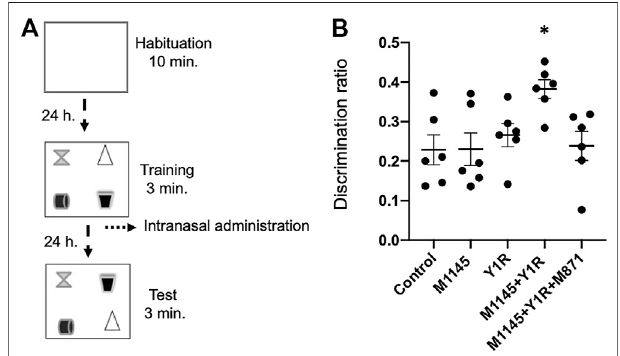
FIGURE 1 | Behavioural effects produced by Galanin 2 receptor agonist (M1145) and the Neuropeptide Y Y1 receptor (NPY Y1) agonist alone and in combination on retrieval in the Object-in-Place memory task. (A) Schematic representation of the procedures followed to perform the behavioural experiments in the Object-in-Place task. The animals performed the task in three phases, separated 24 h from each other, where they explored freely during 10 min in the habituation phase without objects, 3 min in the training phase with fourdifferentobjects, and fi nally3 min inthetest phase withtwoof the objects with the exchanged position. The pharmacological treatments were administered intranasally to the different groups of animals 24 h before the testing phase. (B) The graphic shows the ability of rats to discriminate the exchanged objects at 24 h post-training after the administration of M1145 in combination with the NPY Y1 agonist in the Object-in-Place task. The response induced by M1145 and the NPYY1 coadministration after the acquisition phase improves object-in-place performance following a 24-h delay. Moreover, this effect is blocked by the GAL 2 receptor (GALR2) antagonist M871. Data represent mean ± SEM of the discrimination ratio during the 3 min of the test phase. N = 6 animals in each group. * p < 0.05 vs. the rest of the groups according to one-way ANOVA (F4, 25 = 3.56) followed by Newman-Keuls post-hoc test. Abbreviations: Control = Distilled